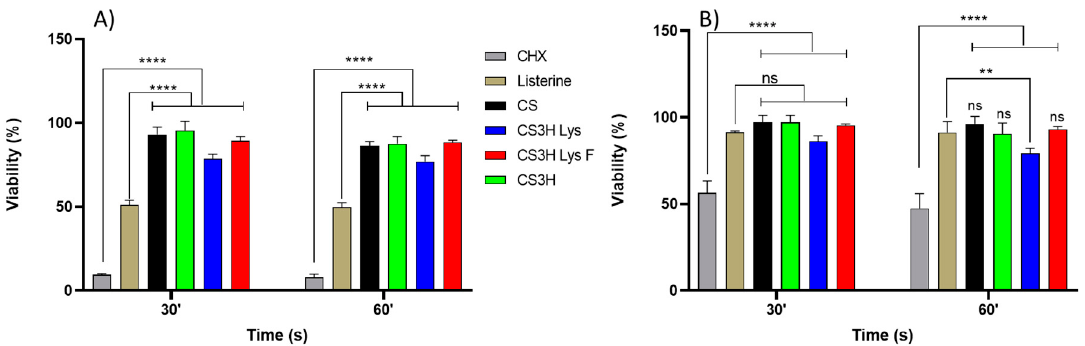
Figure 5. Cytocompatibility test on HGF cells of undiluted mouthwashes ( A ) and mouthwashes diluted 1:1 v / v with artificial saliva ( B ). Data are given as mean ± SD, n = 4). Data were analysed by two-way ANOVA followed by Dunnett’s multiple comparisons (** p < 0.01; **** p < 0.0001); ns = non- significant.